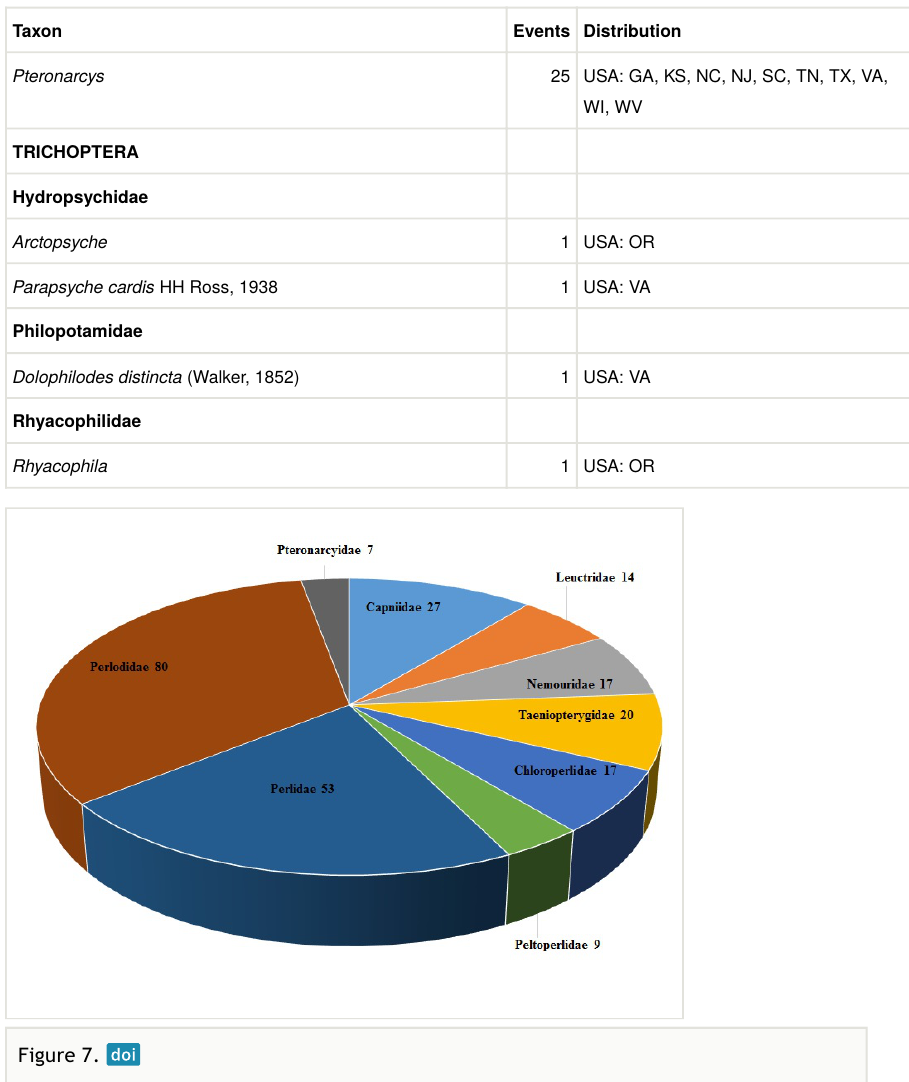
Stone fl ies originated from 9 countries with the United States being represented by 48 states and the District of Columbia with 4,467 site/date events. The other countries represented were Canada with 9 provinces and territories with 51 site/date events; Mexico with 16 events; France and United Kingdom with 3 events each; and Columbia, Mongolia, Panama, and Peru each with 1 event. Within the United States, seven states were represented by 200 to 700 site/date events (Fig. 9): Arkansas, Louisiana, Missouri, and Kansas, Oklahoma, Texas, and Wisconsin.